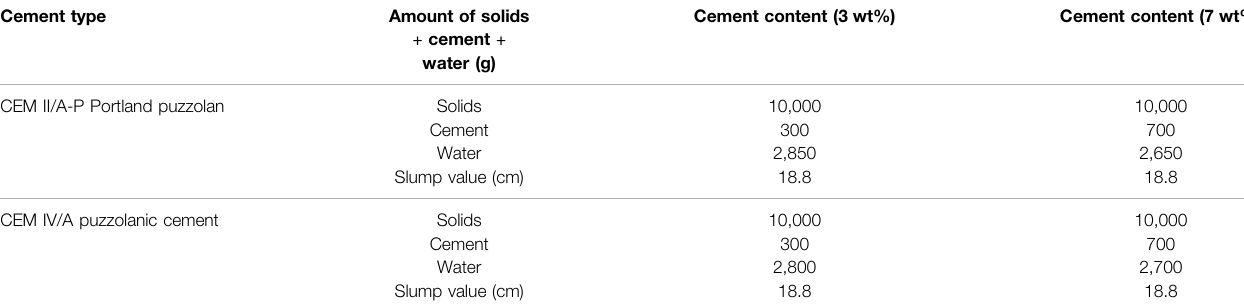
TABLE 2 | A summary of slump recipes of cemented mine back fi lls.